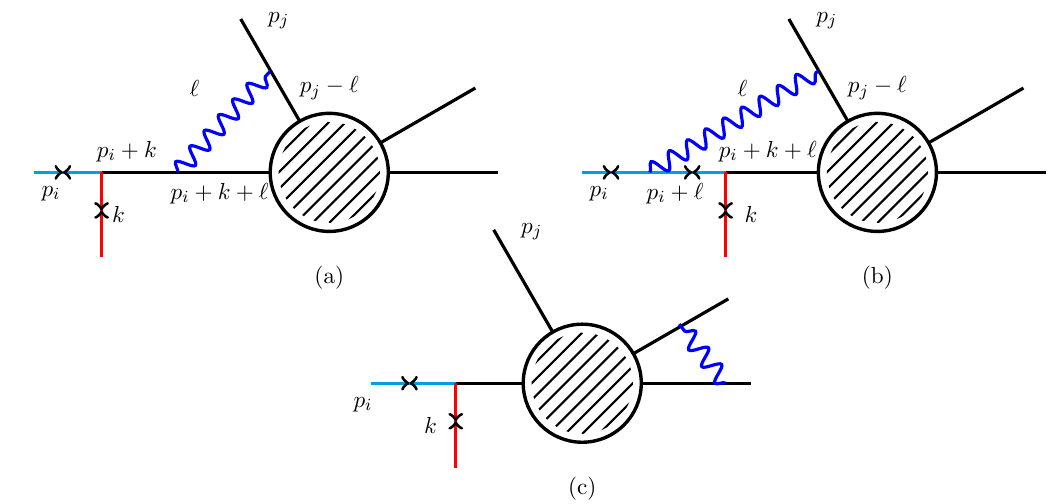
Figure 13 . Infrared divergence in supergravity